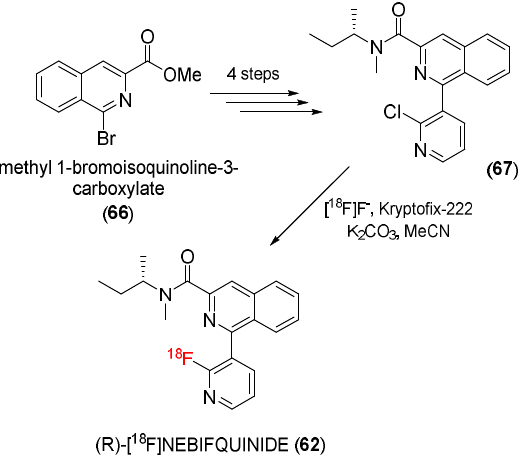
Scheme 19. Synthesis of (R)-[ 18